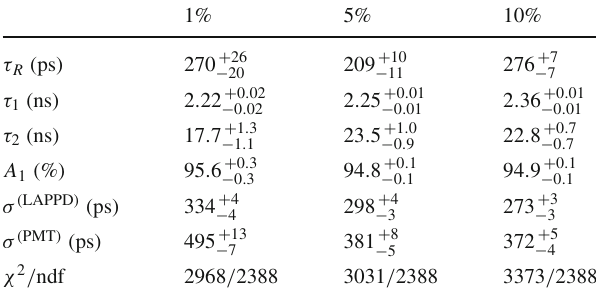
Table 3 The fit results for the WbLS mixtures. The scintillation emis- sion timing parameters are defined in Eq. (6). The values of σ ( LAPPD ) and σ ( PMT ) quantify the effective Gaussian response of the system, driven by MPE timing in the trigger PMT, as discussed in Sect.